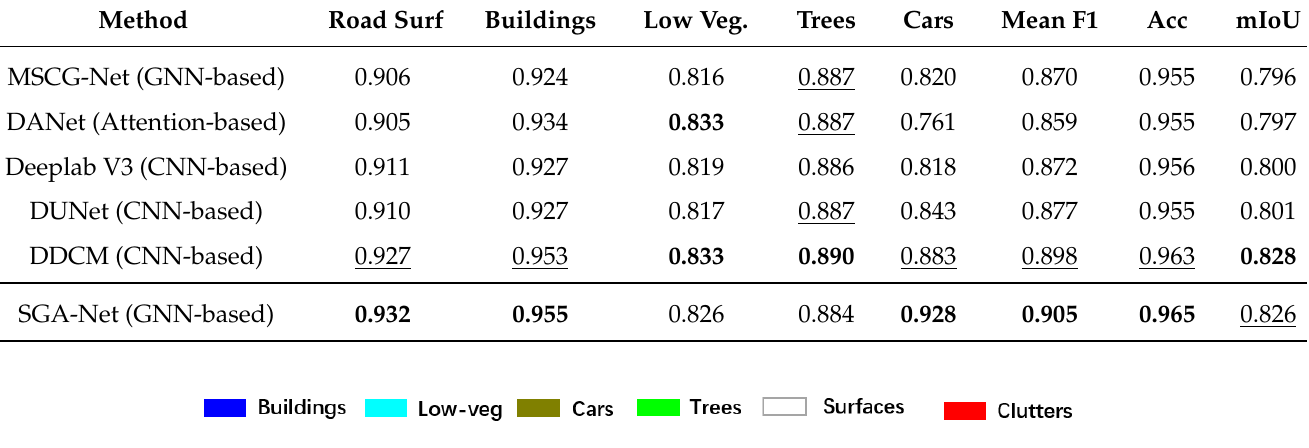
Table 2. The experimental results on the Vaihingen dataset (bold: best; underlined: runner-up). Method